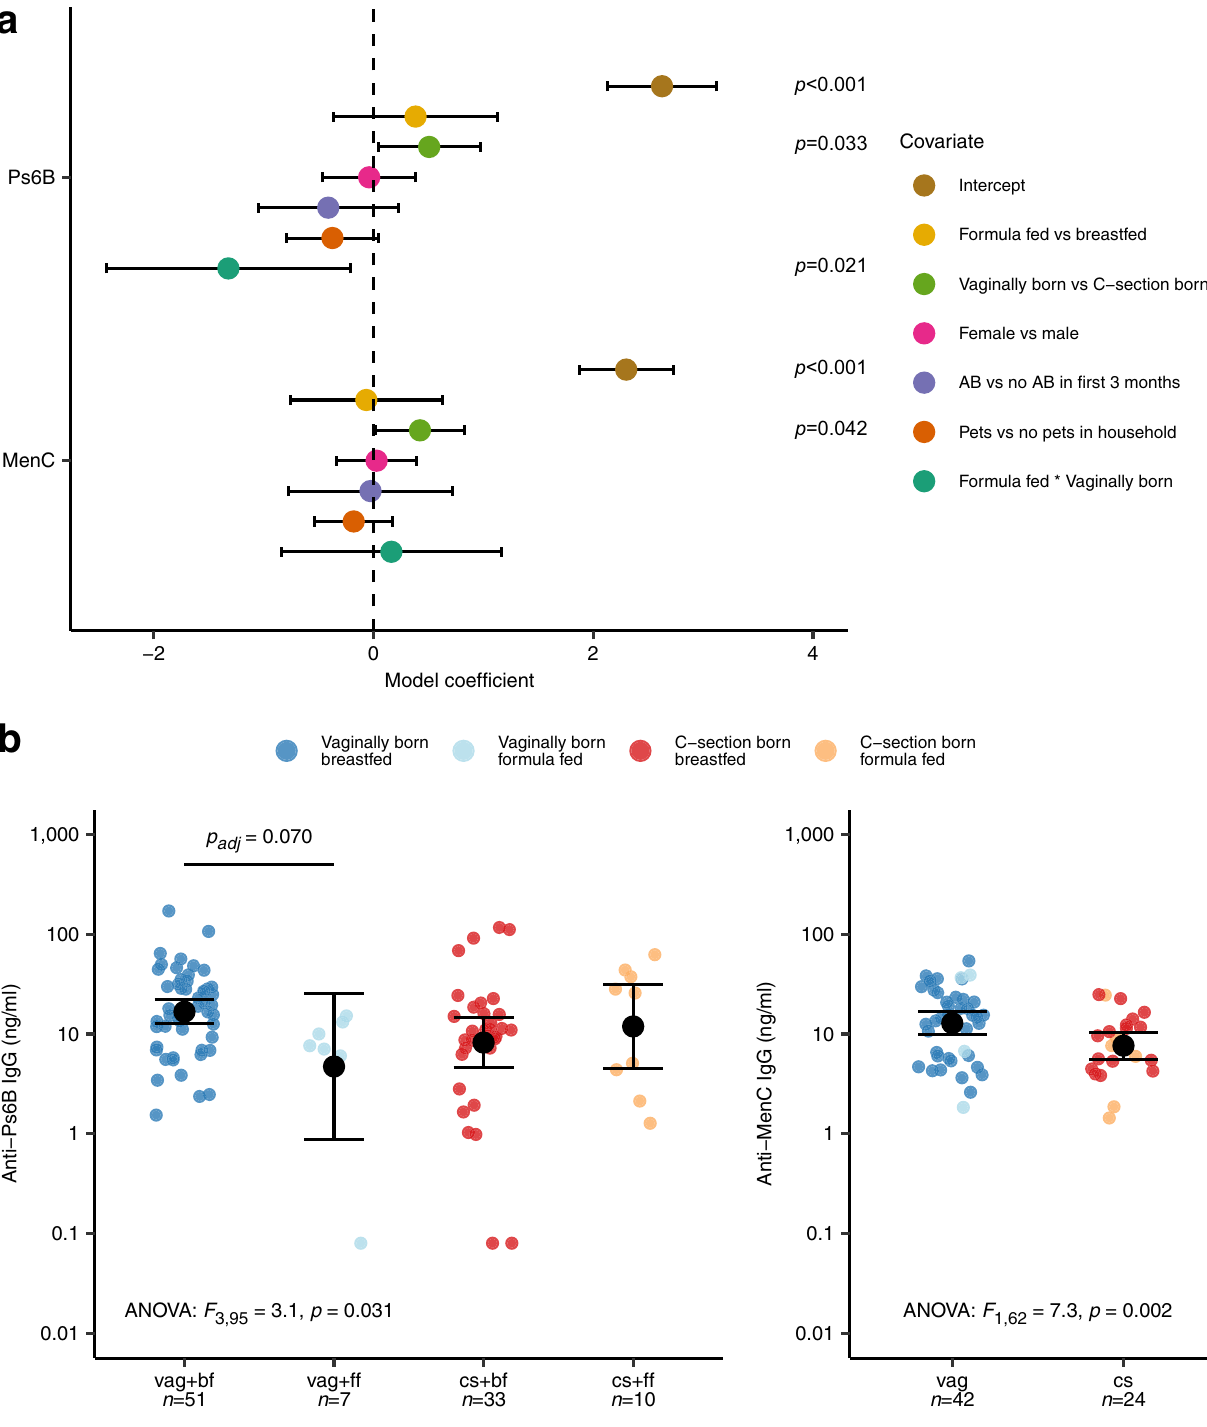
breastfed (cs+bf, n =33), and C-section born, formula fed (cs+ff, n =10) infants (left),andanti-meningococcustypeC(anti-MenC)IgGresponsesforvaginallyborn (vag, n =42)andC-sectionborn(cs, n =24)infants(right).Blackdotsanderrorbars represent geometric mean concentrations (GMCs) with 95% CI. Signi fi cance was assessed using two-sided analysis of variance (ANOVA) on log-transformed IgG concentrations followed by a post-hoc Tukey – Kramer test, correcting for time between vaccination and IgG measurements. P adj =FDR-adjusted p -value. Source data are provided in the Source Data fi